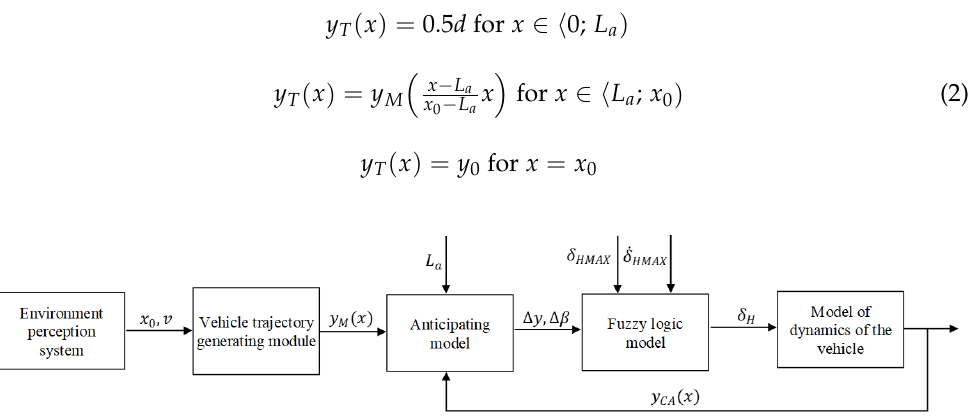
Figure 3. Schematic diagram of the processing of trajectory y M ( x ) in order to determine the steering wheel angle δ H settings.